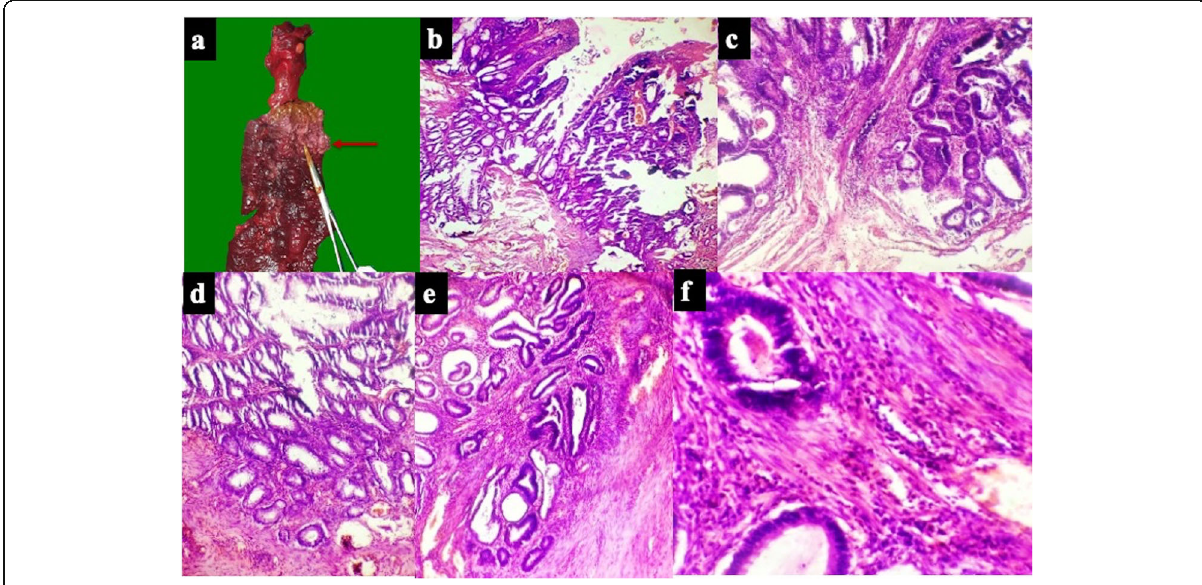
Fig. 4 a Gross image showing a superficial ulcero-proliferative growth in sigmoid (red arrow). b , c Haematoxylin and eosin (H&E) lower magnification (× 40) images showing a tumour mainly arranged in glandular pattern. d , e H&E (× 100) demonstrating an adenocarcinoma infiltrating in to the underlying lamina propria. f H&E (× 400) shows individual glands having hyperchromatic nuclei with loss of nuclear stratification with intraluminal “ dirty ” necrosis, along with interspersed area showing mild acute and chronic inflammatory cell